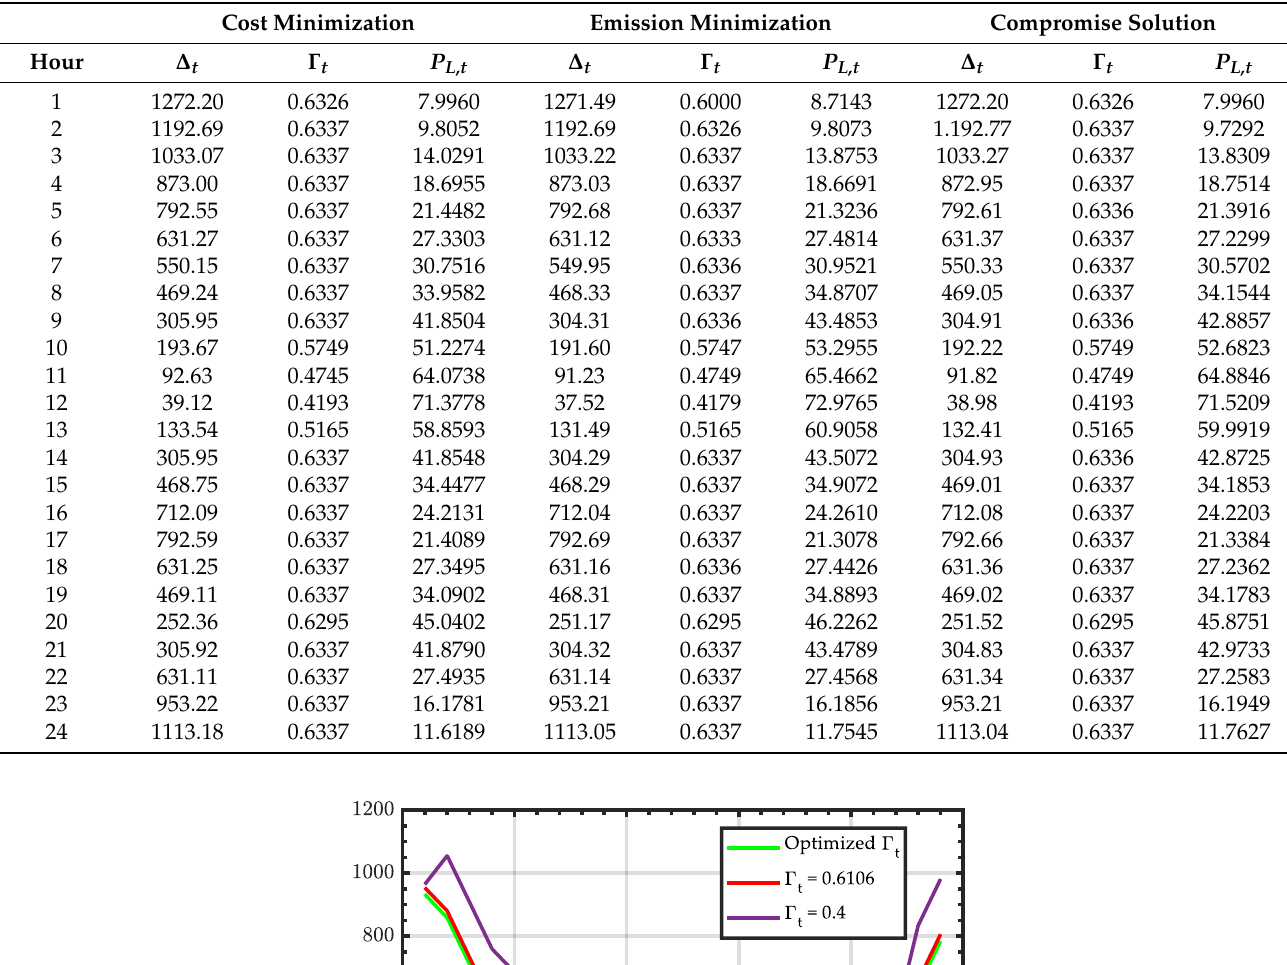
Table 9. Variations of ∆ t , Γ t , and P L , t over the scheduling period.